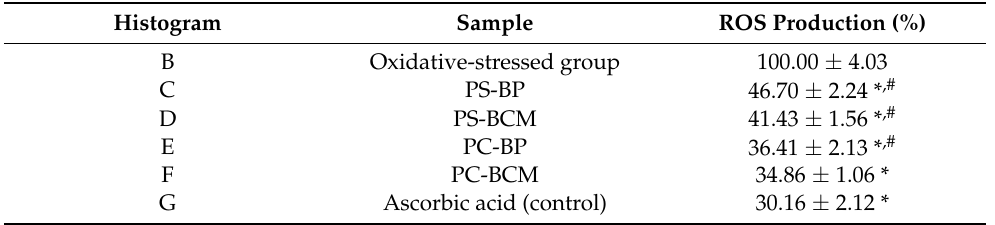
Table 3. Quantification of ROS production in oxidative stressed Caco-2 cells (B) treated with 100 µ g/mL of intestinal digestion products PS-BP (D), PS-BCM (E), PC-BP (F) and PC-BCM (G), per- formed by flow cytometry. Untreated cells (A) and cells treated with 12 µ M ascorbic acid (C) served as a control. The results are expressed as mean ± SD ( n = 3). * p < 0.05, compared to the oxidative stressed group; # p < 0.05, compared to ascorbic acid-treated group.